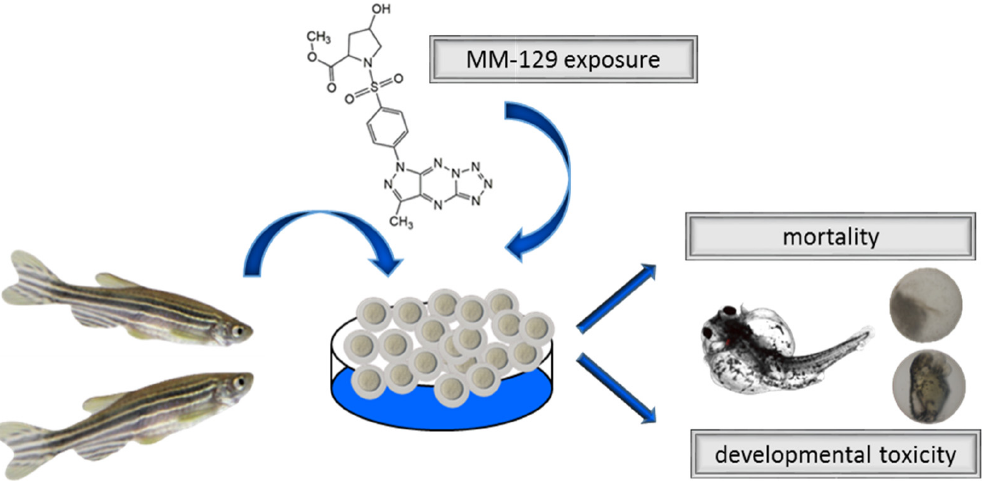
Figure 2. Schematic representation of exposure of zebrafish to MM-129. Abbreviations: MM-129—pyrazolo[4,3-e]tetrazolo[4,5-b][1,2,4]triazine sulfonamide.